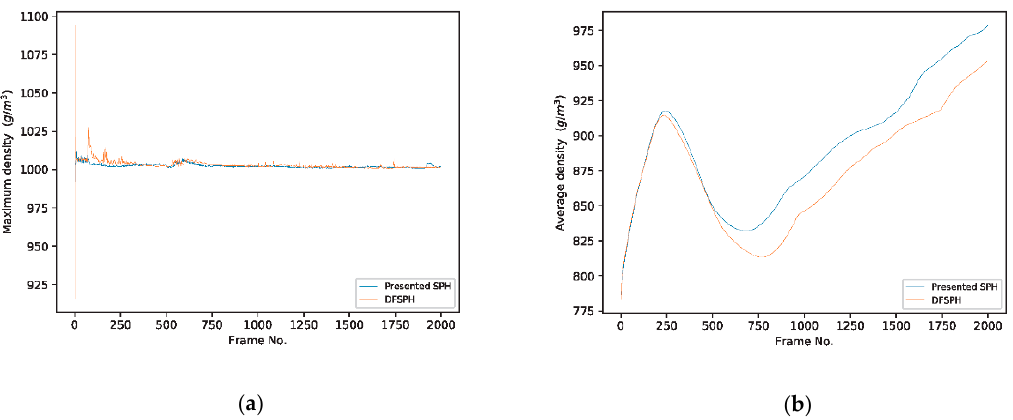
Figure 6. The comparison of incompressibility between DFSPH and our SPH models. The experimental scene is dam break, and the data are taken from the first 2000 time steps. ( a ) The maximum density of fluid particles in each time step. The orange and the blue curves in ( a ) are the maximum densities of DFSPH method and our method, respectively. ( b ) The average density of fluid particles in each time step. The orange and the blue curves in ( b ) are the average densities of DFSPH method and our method.